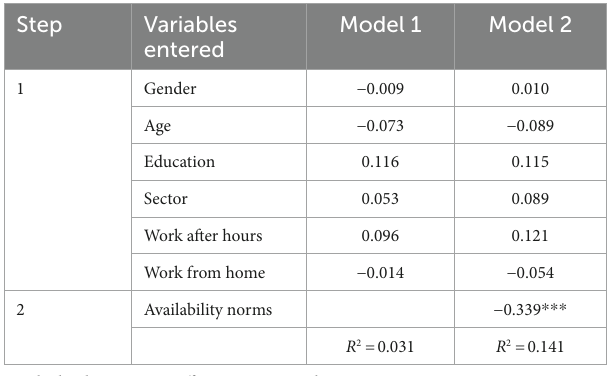
TABLE 5 Multiple linear regression of Job autonomy on predictor variables.